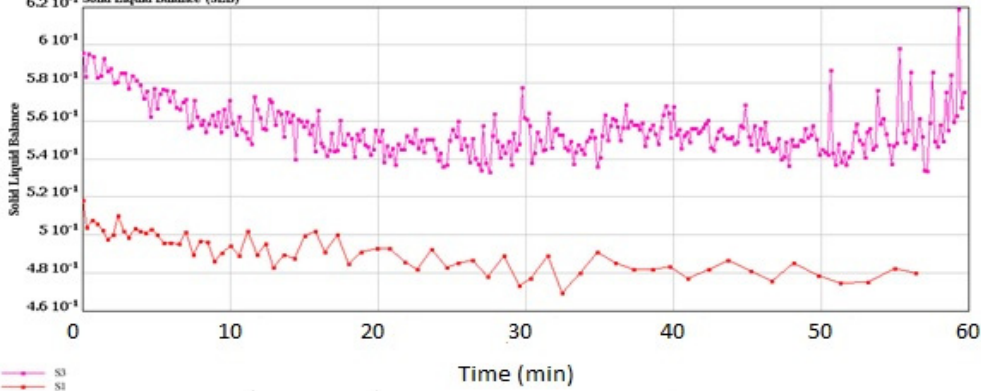
Figure 6. Solid–liquid balance (SLB) values of the control plain yogurt (S1) and synbiotic yogurt with 0.5% Saccharomyces boulardii + 1% inulin (S3).